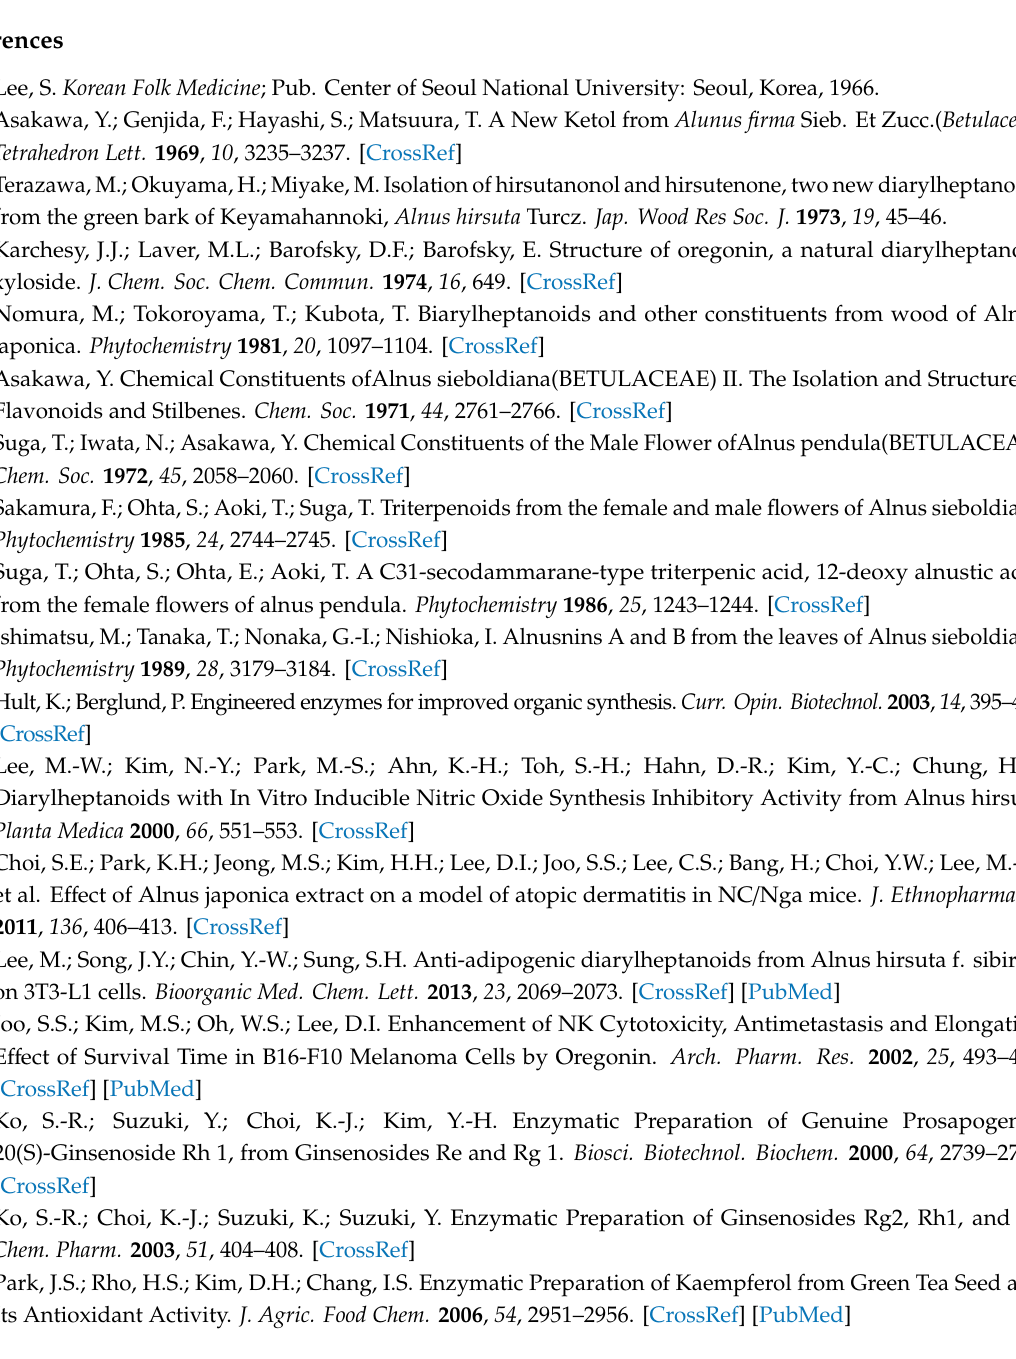
Table S1: 1 H-NMR date of compound 1, Table S2: 1 H-NMR date of compound 2 , Table S3: 1 H-NMR date of compound 3 , Table S4: 1 H- and 13 C-NMR date of compound 4